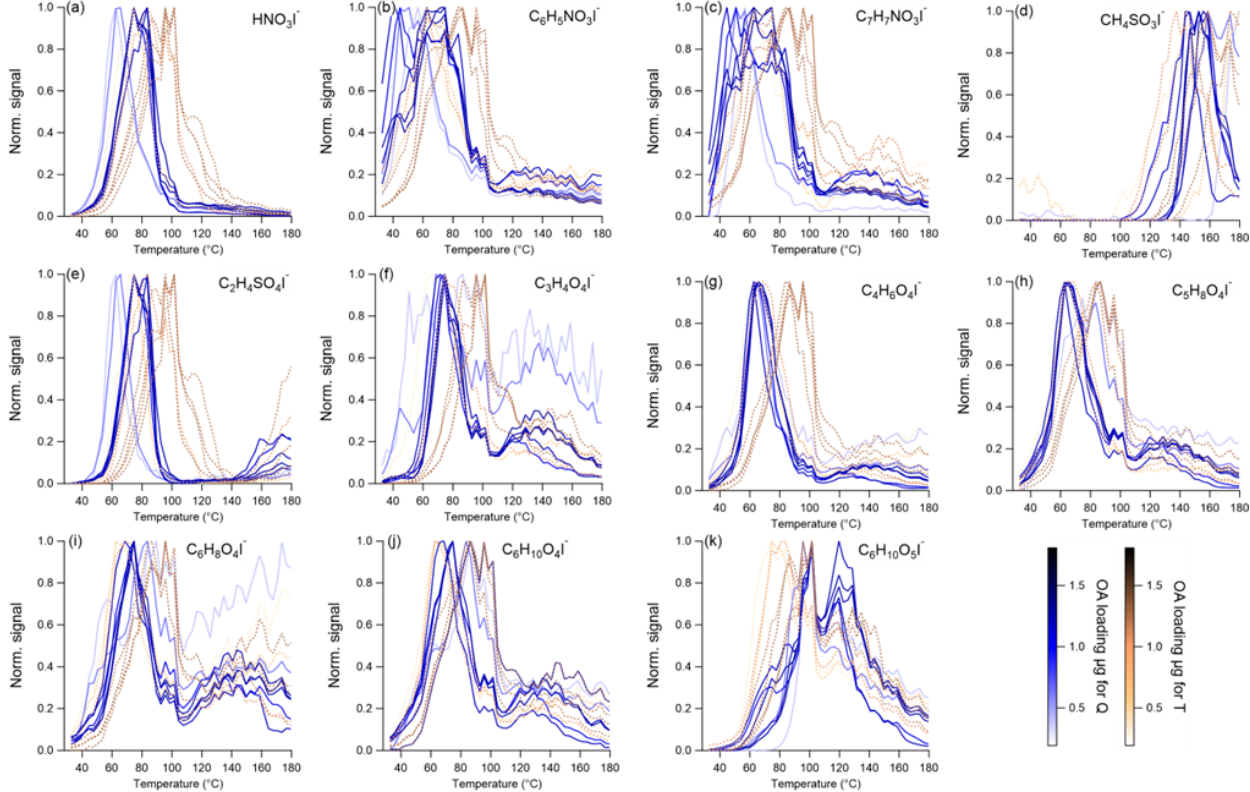
Figure 10. Normalized thermograms for Teflon (T; dashed lines) and quartz (Q; solid lines) filters of (a) HNO 3 I − , (b) C 6 H 5 NO 3 I − , (c) C 7 H 7 NO 3 I − , (d) CH 4 SO 3 I − , (e) C 2 H 4 SO 4 I − , (f) C 3 H 4 O 4 I − , (g) C 4 H 6 O 4 I − , (h) C 5 H 8 O 4 I − , (i) C 6 H 8 O 4 I − , (j) C 6 H 10 O 4 I − , and (k) C 6 H 10 O 5 I − . The thermograms were first corrected (Sect. 2.2.4) and then normalized to signals at T max and colored by the OA mass loading. The sampling information of the thermograms presented here is listed in Table